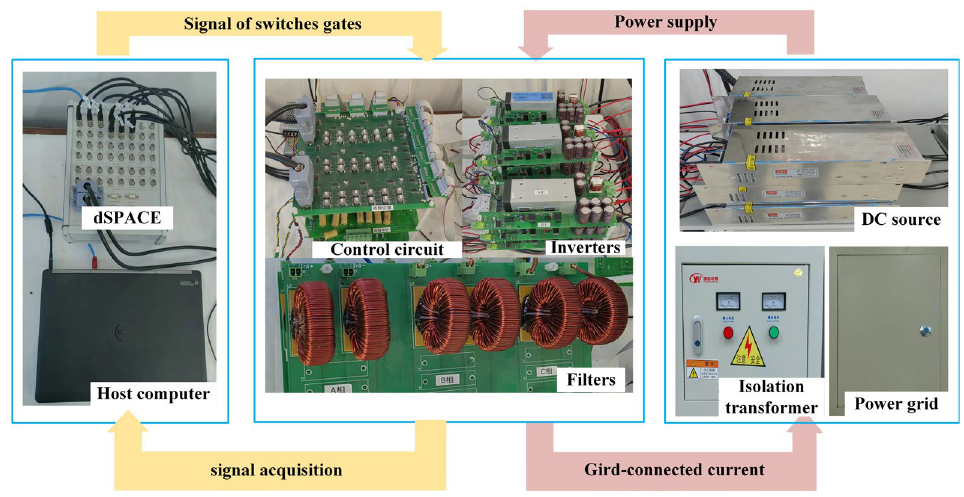
Figure 9. Laboratory built prototype.